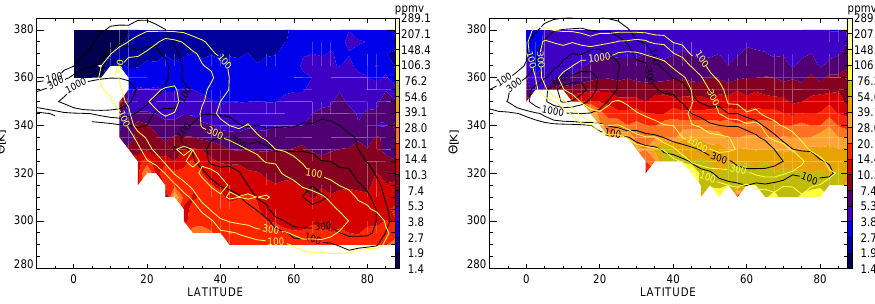
Fig. 8. As Fig. 3 but for the saturation mixing ratio H 2 O LCP , sat of all TST-trajectories projected to t =0 for northern winter (left) and summer (right). Colours from yellow to blue indicate the transition from high to low water vapour mixing ratios. For those trajectories with LCP-saturation H 2 O LCP , sat > 5 ppmv black contours indicate the location of LCP, yellow contours show the location of TST (number in 2 . 5 ◦ × 2 . 5 ◦ × 5 K-bins).